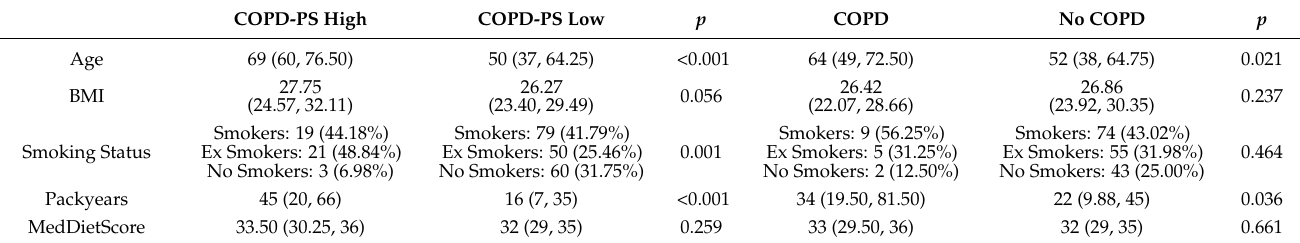
Table 2. Participants at high risk for COPD according to